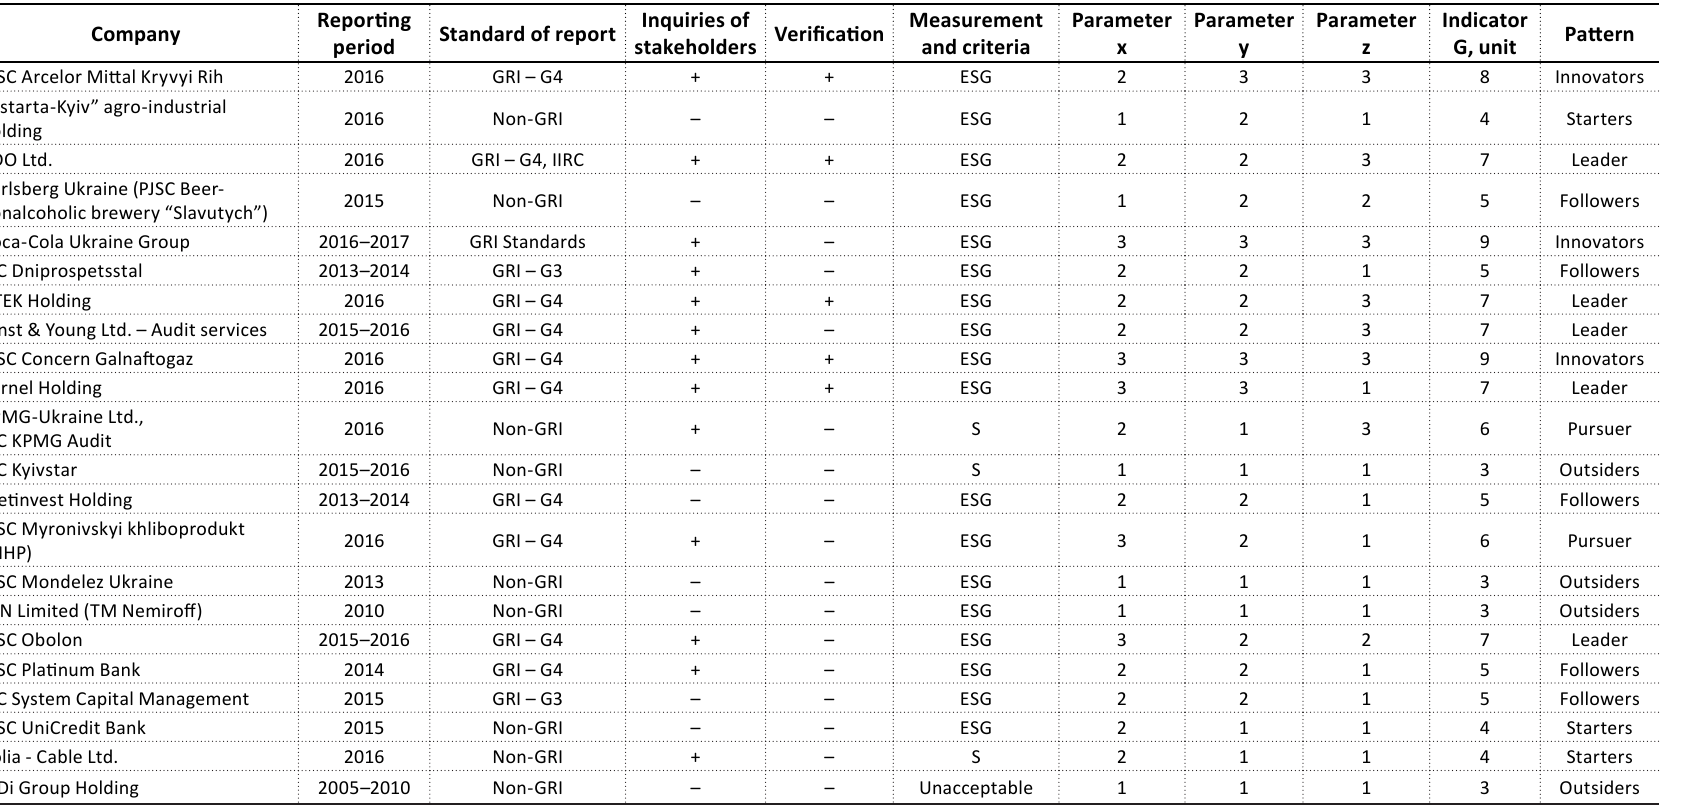
Source: Compiled by the